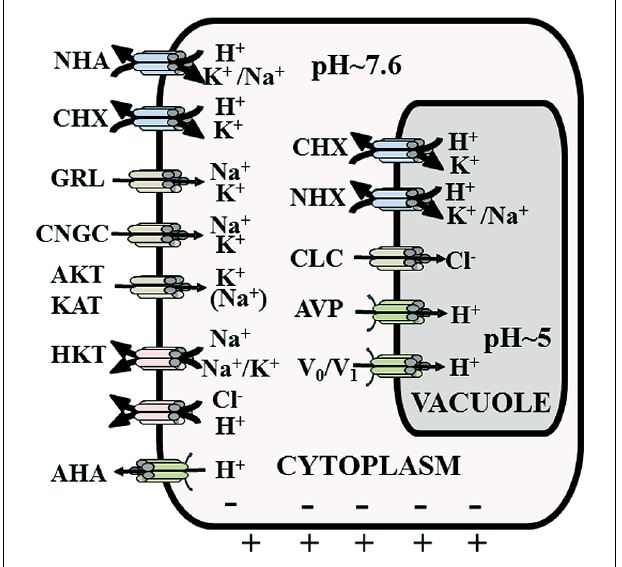
FIGURE 2 | Overview of the main membrane transporters that contribute to Na + and Cl − uptake and distribution. Not necessarily all depicted proteins are expressed in one cell. AHA, H + pump; AKT/KAT, K + inward rectifying channel; AVP, vacuolar pyrophosphatase; CHX, cation-proton exchanger/antiport; CLC, chloride channel; CNGC, cyclic nucleotide gated channel; GRL, glutamate receptor like channel; HKT, K:Na and Na:Na, symporters; NHA, plasma membrane sodium-proton exchanger/antiport; NHX, tonoplast sodium-proton exchanger/antiport; Vo/V1, tonoplast H +